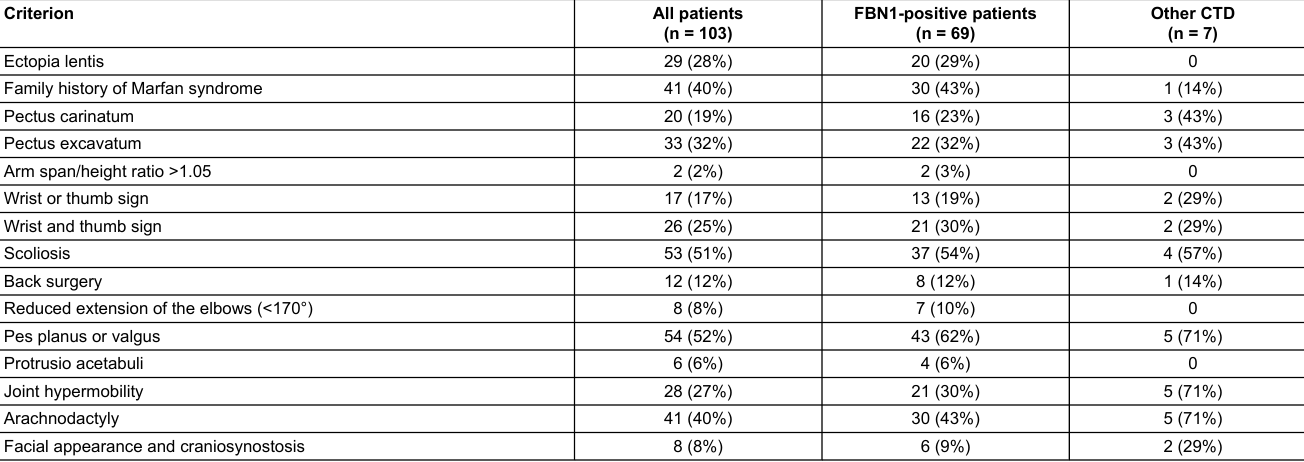
Table 3: Summary of Ghent criteria and other skeletal findings. Criterion